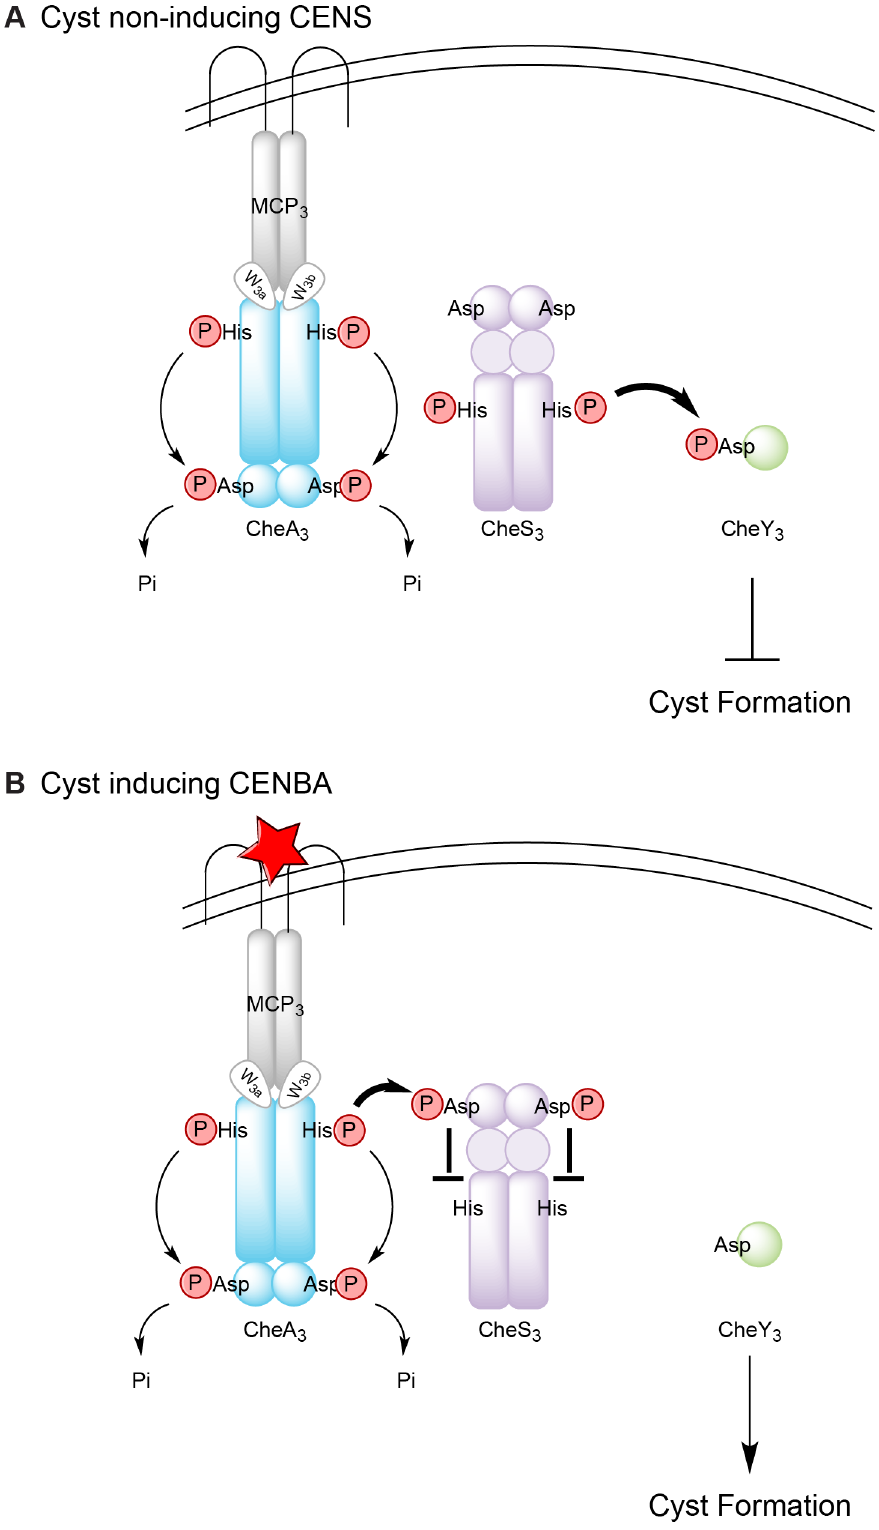
Figure 6. Model for regulation of Che 3 signal transduction pathway. (A) In the absence of unknown signals, CheA 3 is deactivated; CheS 3 autophosphorylates and transfers phosphates to its cognate response regulator CheY 3 ; activated CheY 3 then interacts with downstream components to repress cyst formation. (B) In the presence of an unknown signal (denoted by a red star), CheA 3 autophosphorylation is activated;